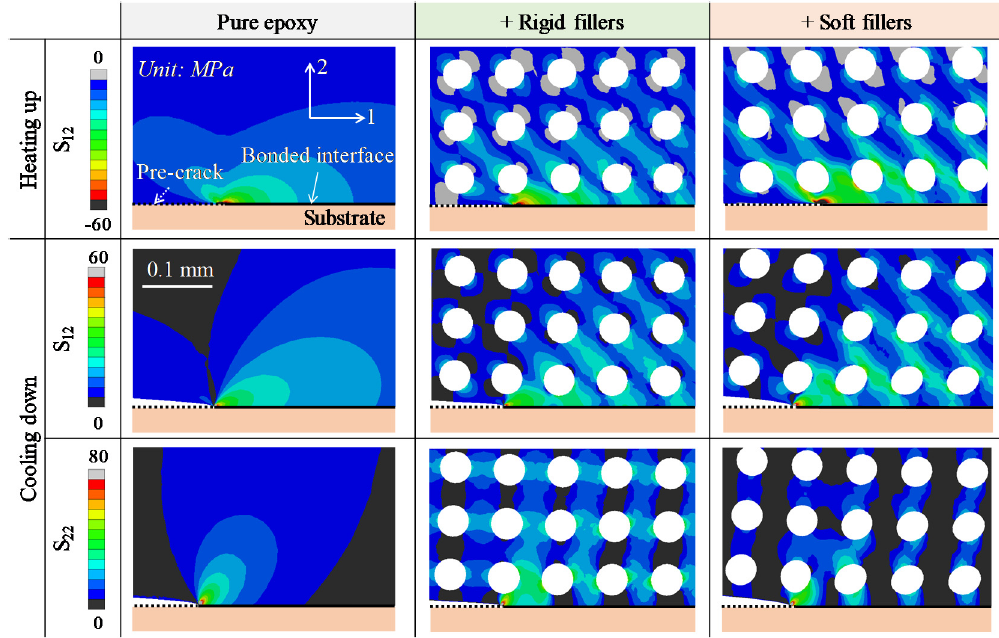
Figure 9. Stress distribution around the crack tip. (The fillers are hidden for simplicity, and the displacements are magnified five times in the deformed model).